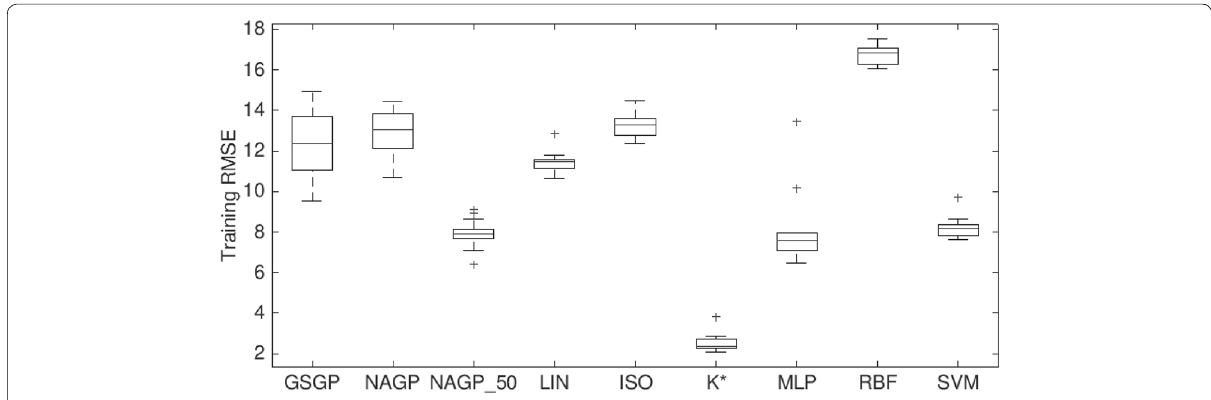
Fig. 9 Root mean squared error on the training